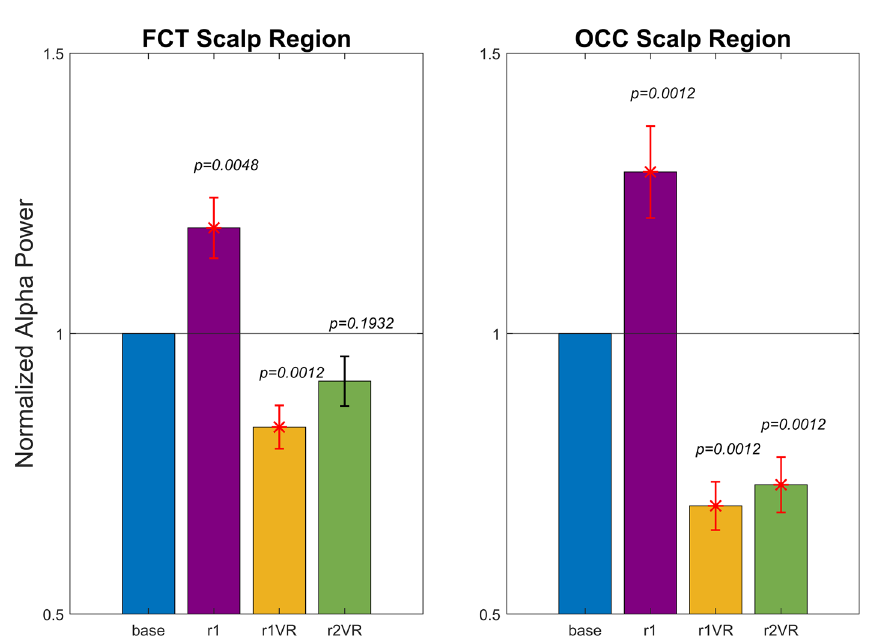
Figure 4. Normalized alpha power, averaged across all participants (mean ± sem), over the fronto-central- temporal FCT scalp region (left panel) and over the parietal-occipital OCC scalp region (right panel) during each of the three phases (r1, r1VR, and r2VR) of the sessions. Since normalization was performed relative to baseline condition (see “Methods” section), normalized alpha power was equal to 1 in the base phase in each participant and region, and was reported for clarity. The figure also shows results of the two-tailed permutation test for dependent samples obtained comparing the normalized alpha powers in each phase r1, r1VR and r2VR with the base , separately within each region. Error bars are coloured in red when the considered phase compared to the base was statistically significant (Bonferroni corrected p-value < 0.05), while these are coloured in black in the absence of